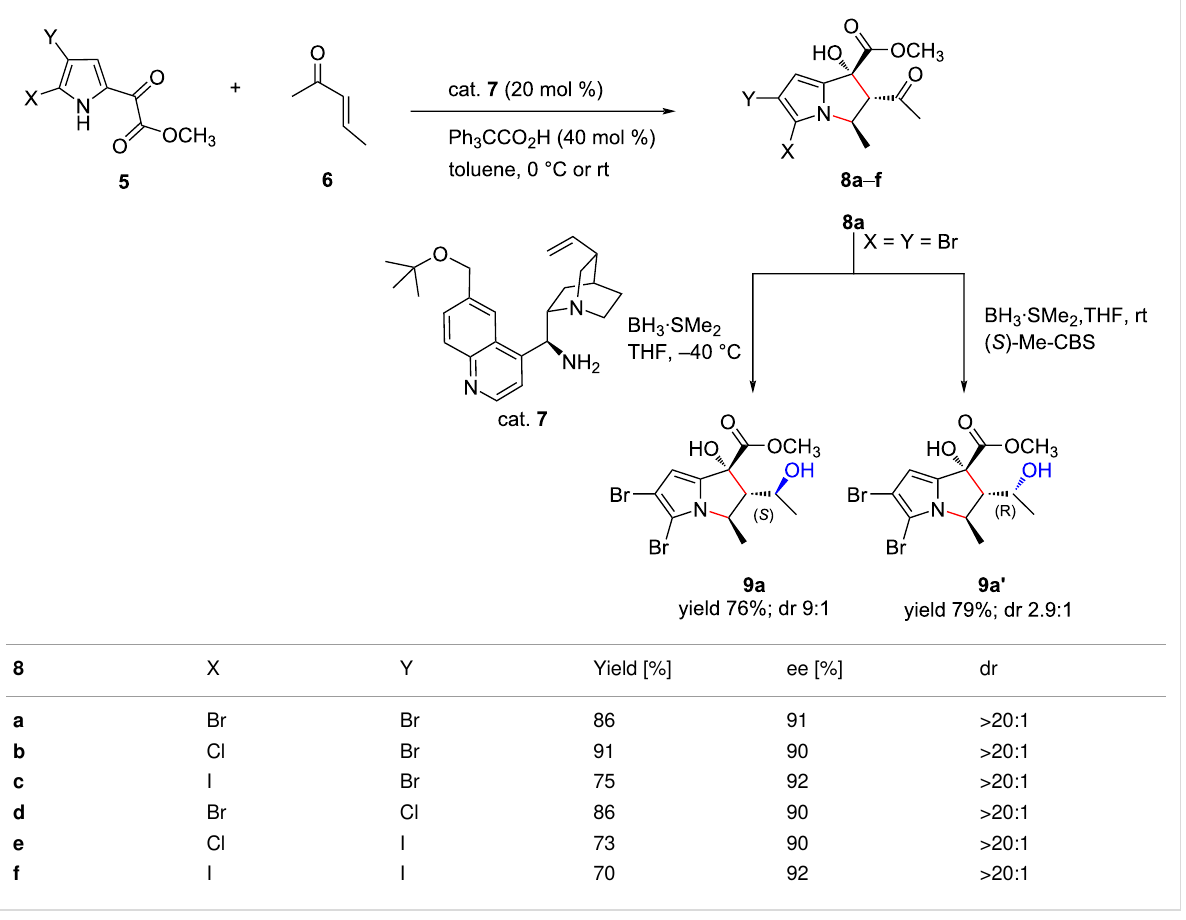
Table 1: Asymmetric cascade aza-Michael − aldol reactions of α , β -unsaturated ketones with